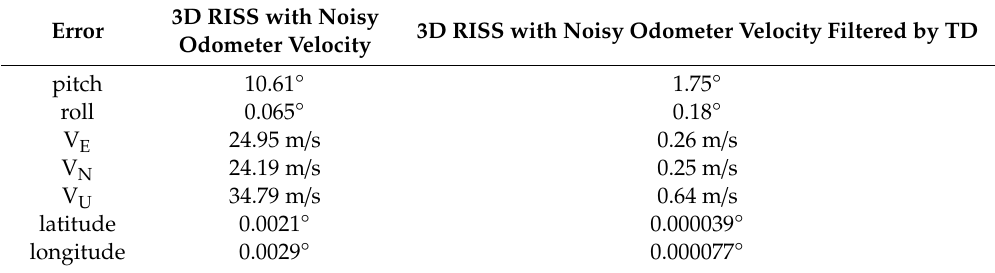
Table 2. Deviations of the main navigation errors between the two 3D RISSs with noisy odometer velocities and the